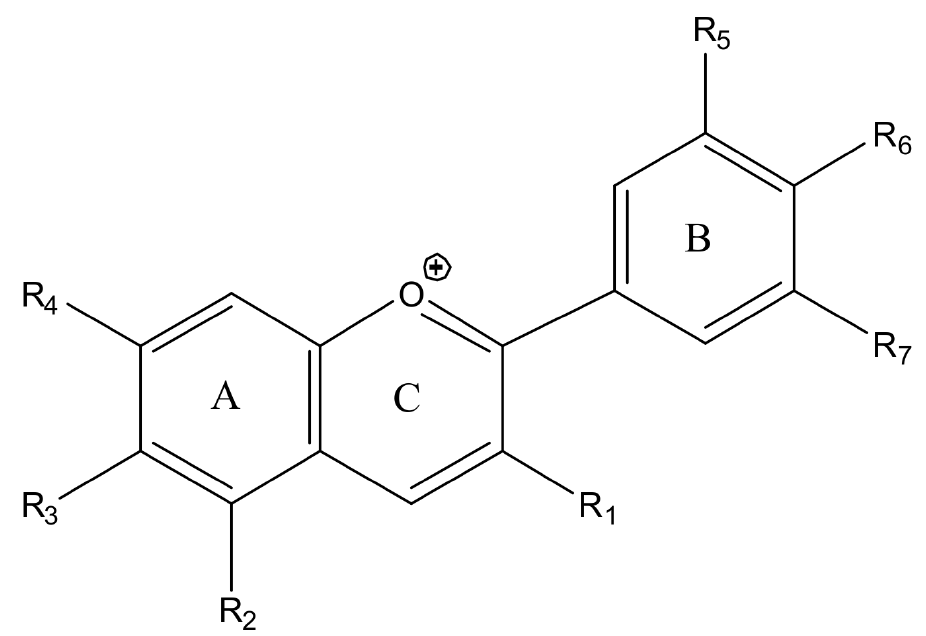
Figure 1. Basic structure of anthocyanidins. Table 1. Substitution patterns in